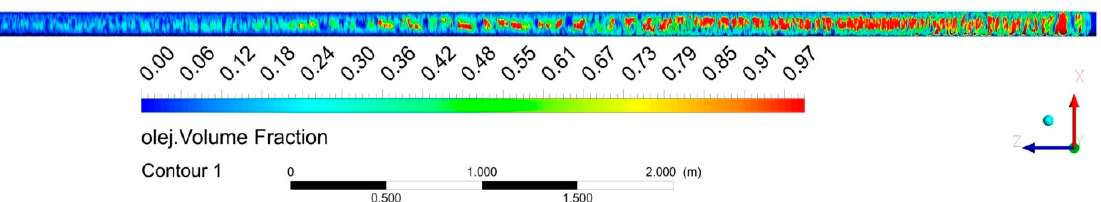
Figure 6. Volume of the oil at the surface of the pipe over its full length at the speed of 5.5 m / s with a pipe diameter of 25 mm.